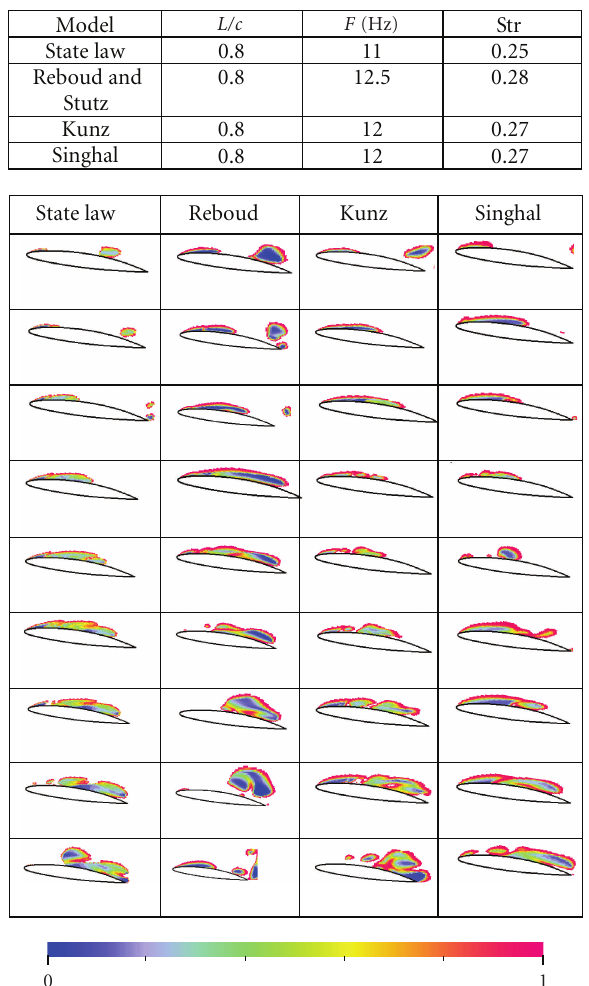
Figure 19: Numerical results obtained with di ff erent models ( σ = 1 . 3, V ref = 5 . 33m · s − 1 , Δ t = 0 . 011